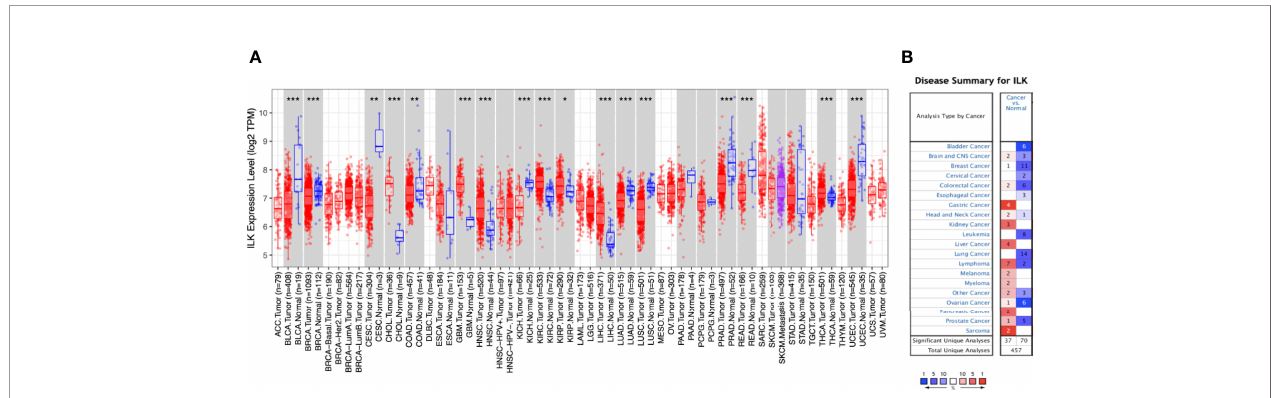
FIGURE 1 | Differential expression of ILK mRNA in cancers and normal tissues. (A) Differential ILK mRNA expression between different human cancers and their adjacent normal tissues from TCGA was evaluated via TIMER (*P < 0.05, **P < 0.01, ***P < 0.001). (B) The expression levels of ILK mRNA in independent datasets in different cancers compared with normal tissues were assessed by Oncomine. The thresholds were P -value of 0.001, fold change of all, and gene ranking of all. The red cells represent cancer datasets and the blue cells normal datasets, and the numbers inside the cells indicate the number of independent datasets. The color intensity is an indicator of the gene rank